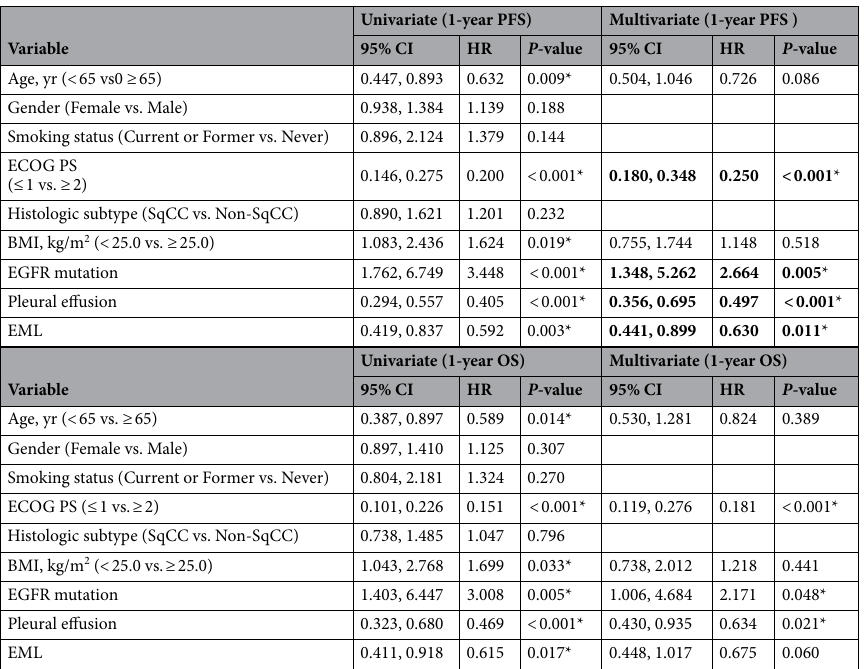
Table 3. Prognostic factors associated with 1-year PFS and OS in NSCLC patients. Significant values are in bold. BMI body mass index, ECOG PS Eastern Cooperative Oncology Group performance status,